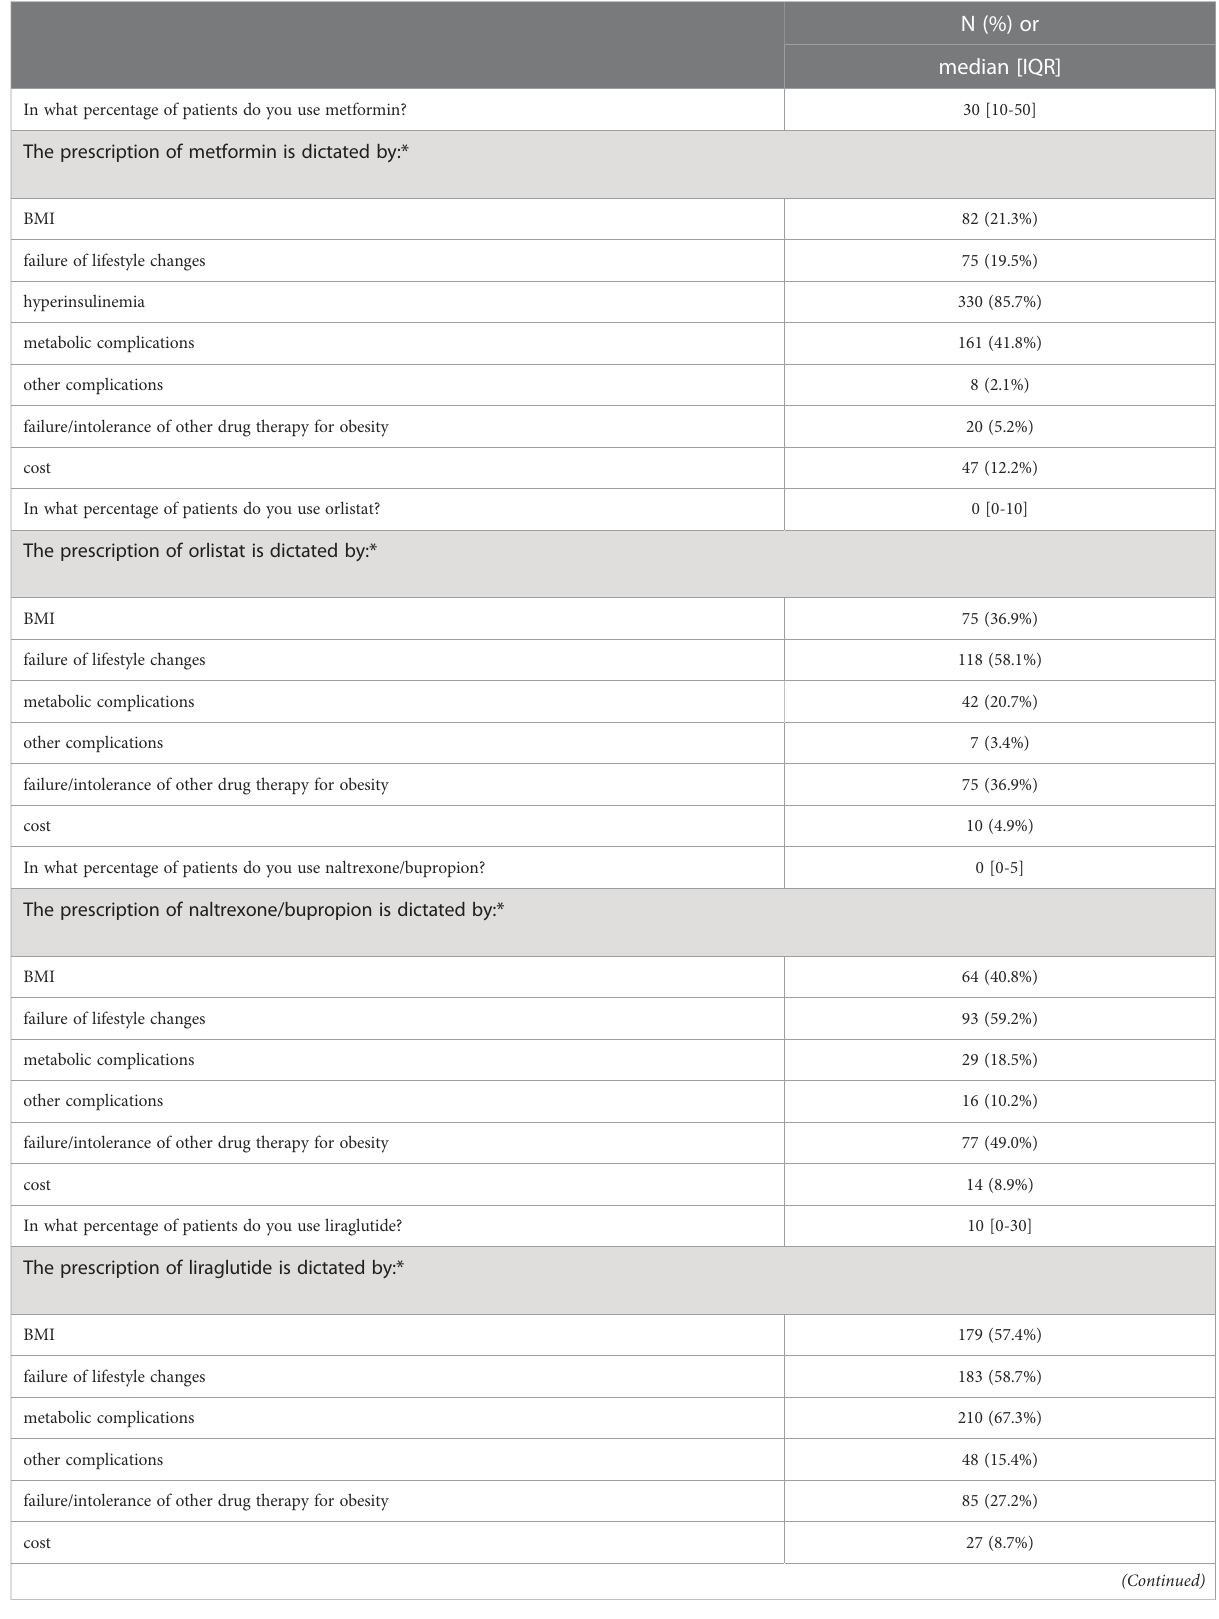
TABLE 4 Pharmacological treatment of